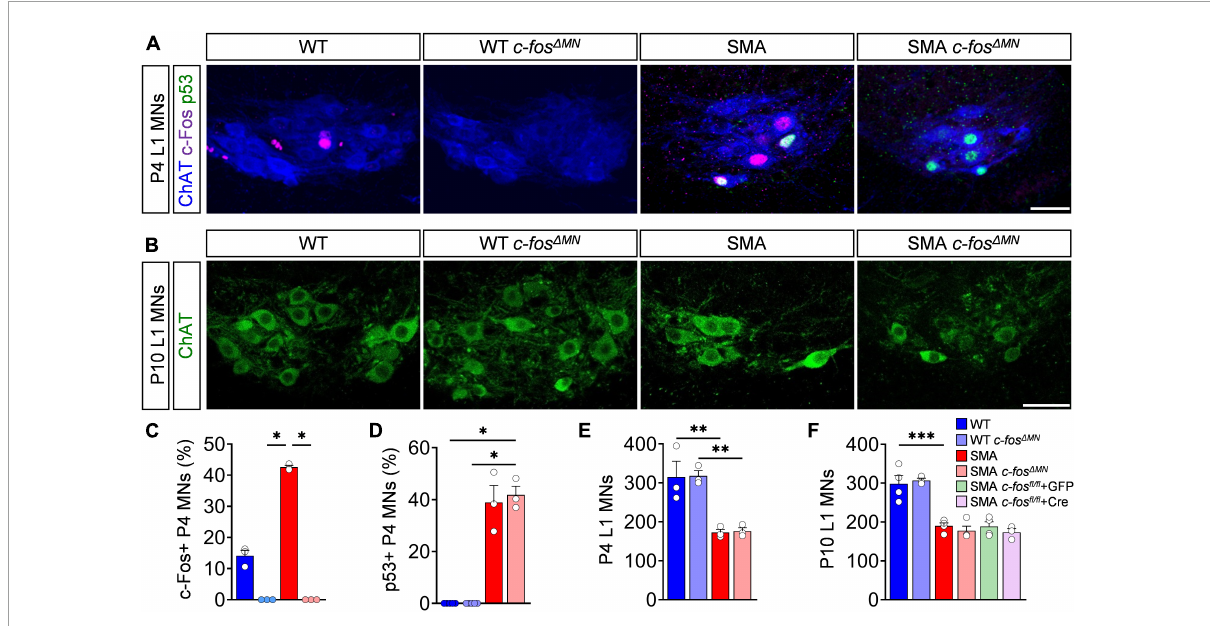
FIGURE3 c-Fos deletion in spinal muscular atrophy (SMA) motor neurons does not prevent their death. (A) Immunostaining of c-Fos (magenta), p53 (green), and ChAT+ (blue) of L1 motor neurons (MNs) from P4 control wild-type (WT), SMN (cid:49) 7 mutant (SMA) and control (WT c-fos (cid:49) MN ) or SMN (cid:49) 7 mutant ( c-fos (cid:49) MN ) with MN-specific c-Fos knockout, respectively. Scale bar = 50 µ m. (B) Immunostaining of ChAT + (green) L1 MNs of P10 mice from the same group as in panel (A) . Scale bar = 50 µ m. Quantification of c-Fos (C) , p53 (D) positive L1 MNs in% and L1 MN numbers (E) from the same group as in panel (A) . (F) Quantification of L1 MN number from P10 mice from the same group as in panel (A) plus AAV9-Cre (induce postnatal c-Fos deletion in MNs) or AAV9-GFP (control virus) injected SMN (cid:49) 7 mice containing homozygous floxed c-Fos genes (SMA c-fos fl / fl ). n = 3–5 per genotype. Statistics: Kruskal–Wallis test for panels (C,D) , one-way ANOVA with Tukey’s correction for panels (E,F) . Each data point (n) represents one animal. Asterisks on top of bars without horizontal line indicate the significance compared to another group. ** p < 0.01; *** p <